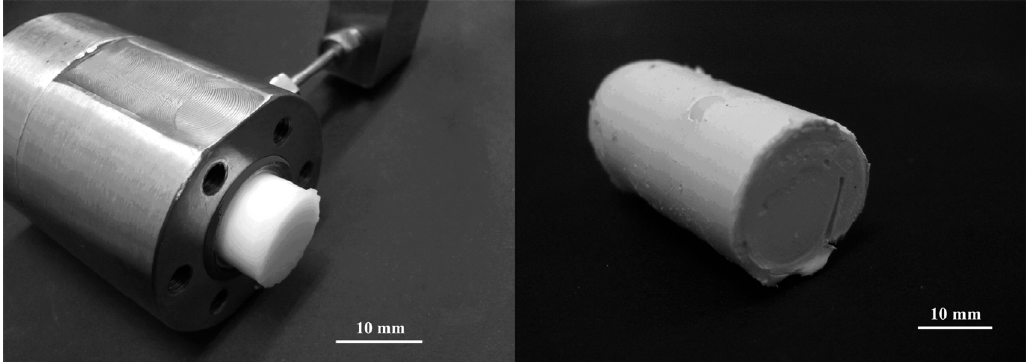
Figure 11. Photograph of a low-density C/W emulsion templated PAM-based